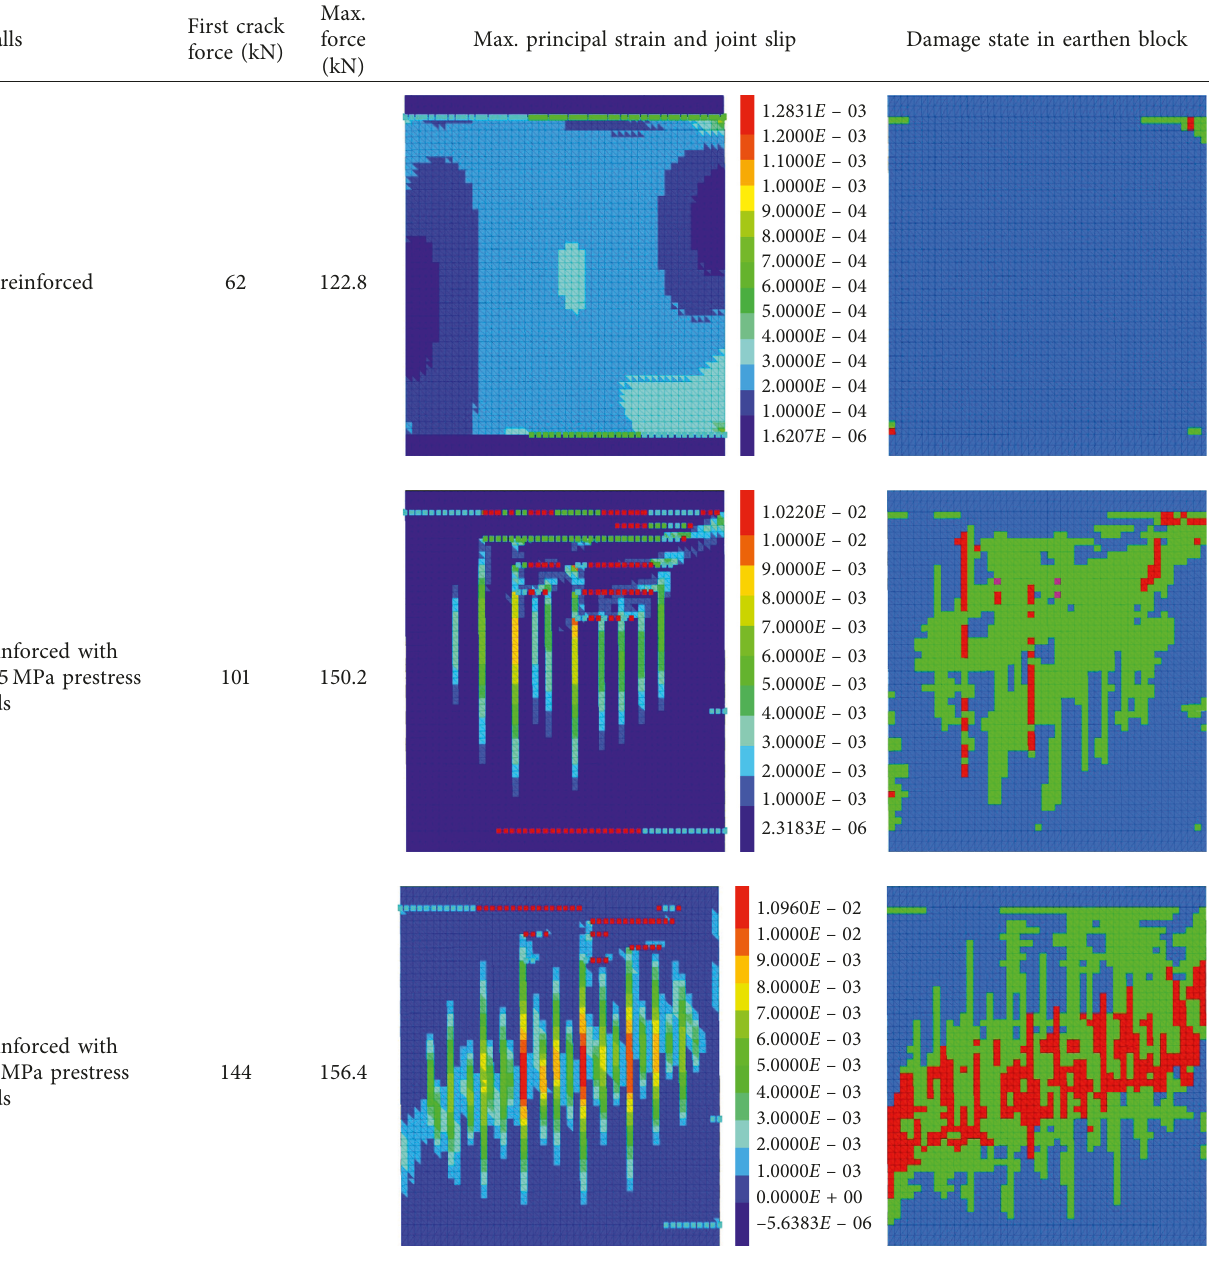
Table 2: Damages and force obtained (the pushing direction is the same as in Figure